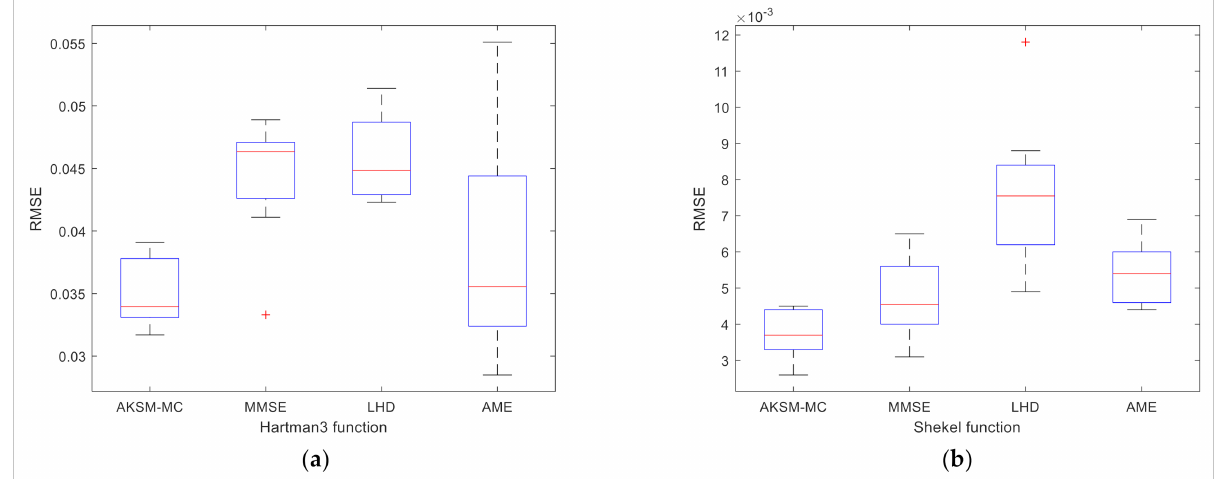
Figure 13. ( a ) Box plot of test results for Hartman3 function; ( b ) Box plot of test results for Shekel function.